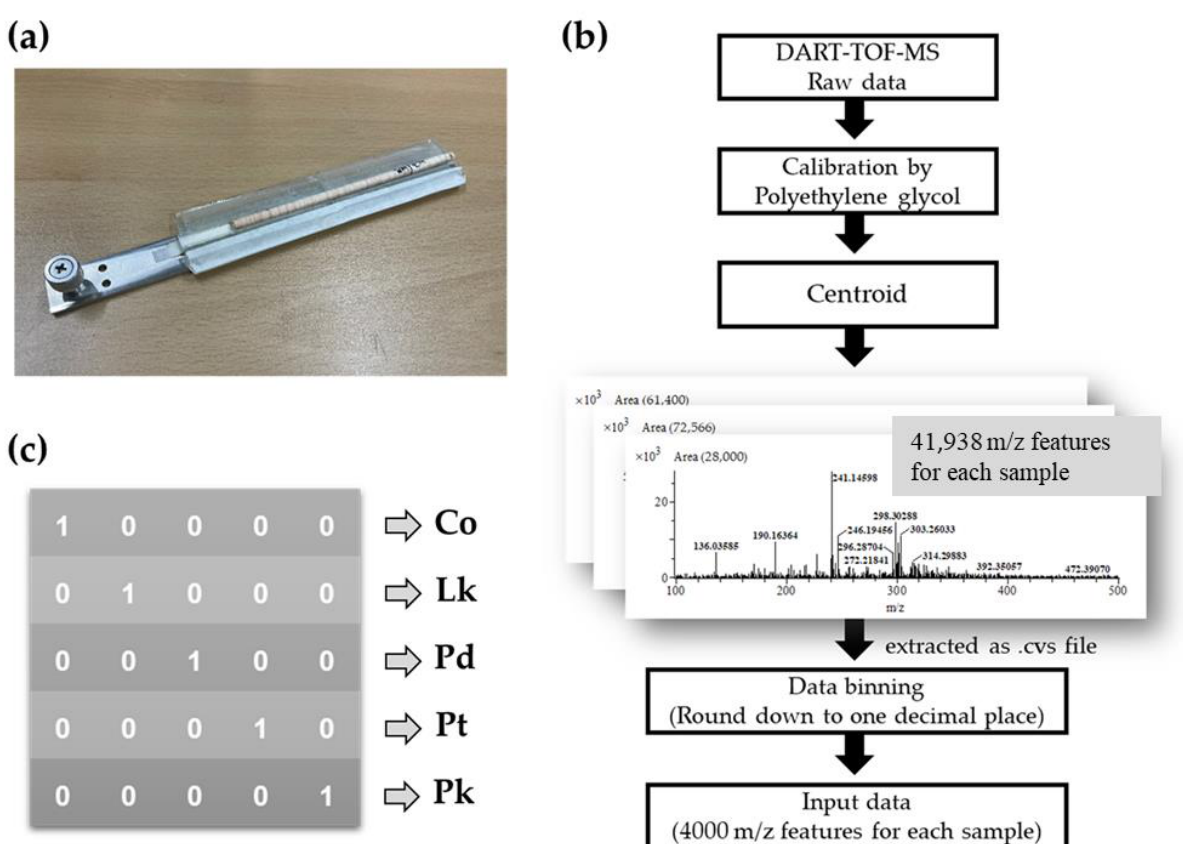
Figure 1. ( a ) A lab-made wood sample tray module for DART-TOF-MS analysis; ( b ) process flow diagram for mass spectral data preprocessing; ( c ) one-hot encoding for target data.